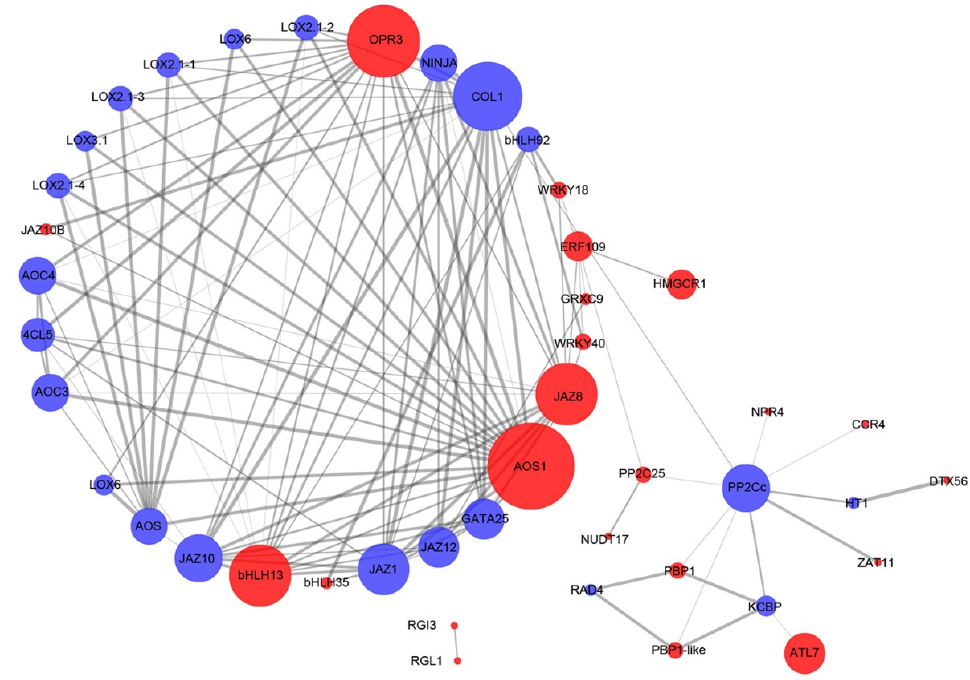
Figure 5. PPI regulatory network of hub genes in the magenta module. Red nodes refer to hub genes identified in the magenta module; blue nodes refer to genes in the genome that interacted with hub genes. The size of the nodes is based on degree. The width of the edges is based on the confidence score.